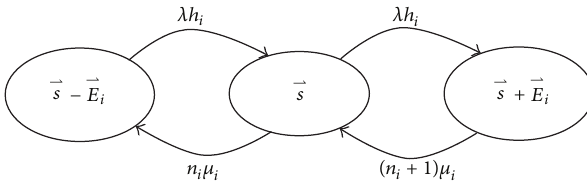
Figure 1: State transition